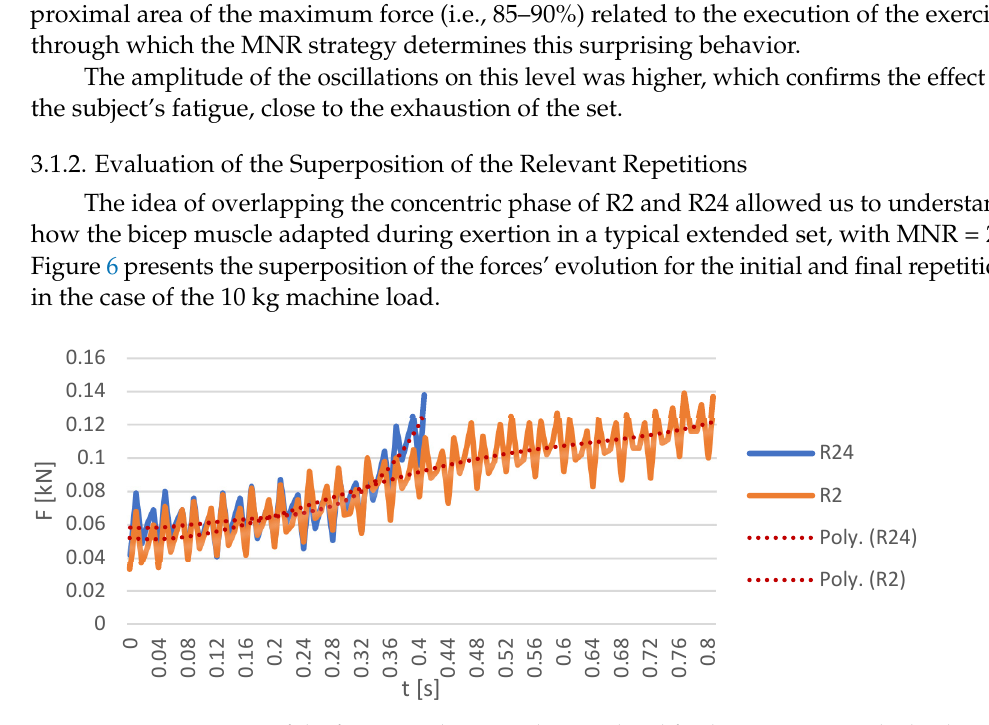
Figure 5. Evolution of forces versus time—10 kg load for cycle of an initial repetition ( a ) and of a final repetition ( b ).